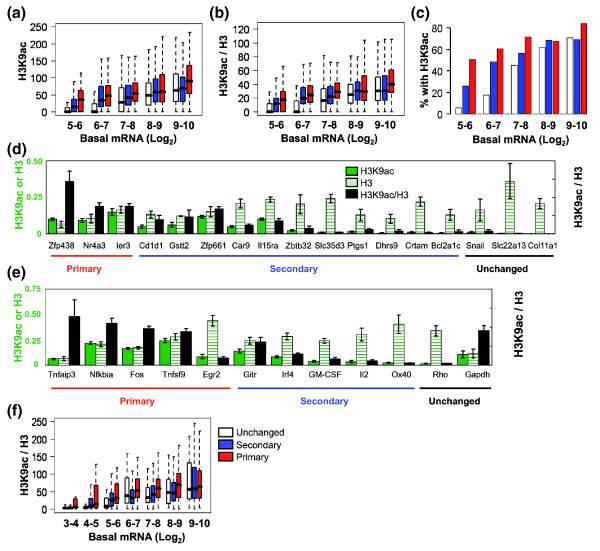
Inducible genes have higher levels of H3K9ac at their promoters. The H3K9ac levels determined from ChIP-on-chip experiments are plotted for genes grouped by their kinetics of expression (red, primary response genes; blue, secondary response genes; white, unchanged genes) and their basal expression levels (Log2 robust multichip average values from expression profiling). (a, b) Levels of H3K9ac were compared to either total genomic input DNA (a) or total H3 levels determined by ChIP-on-chip (b). (c) The proportion of promoters with a H3K9ac MAT score >35.2 (FDR <5%) was plotted for each of the gene groups. Three biological replicates were performed for each ChIP-on-chip and the data combined (a-c). (d, e) Real-time PCR was used to verify the results of microarrays (d) for a selected group of genes and to examine the H3K9ac levels for a set of well characterized inducible genes at the promoter region (e). In (d) the genes are plotted from the left to right in order of decreasing predicted H3K9ac score from the ChIP-on-chip data (with H3 levels as background control). The H3K9ac/total input (green bars), the H3/total input (hatched green bars) and the H3K9ac/H3 ratios (black bars) are shown (d, e). The averages of three independent experiments are plotted; n = 3; error bars = standard error of the mean. (f) Data from ChIP-Seq experiments on human CD4+ lymphocytes [28] were analyzed to determine the number of H3K9ac sequence tags that overlapped with the promoter region (-1 kb to +1 kb) of each gene and the data are plotted for the different gene groups. The basal expression levels of the genes are from a matching human CD4+ lymphocyte microarray analysis [GEO:GSE10437]. The bar marks the median score, the edges of the boxes the second and third interquartile ranges and the whiskers the first and fourth interquartile ranges (a, b, f).